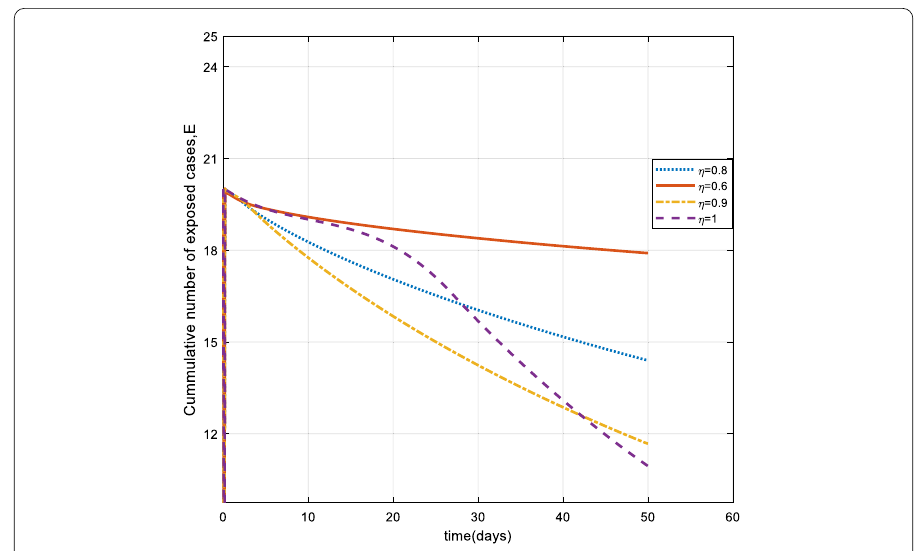
Figure 7 Number of exposed cases (E) with control for different values of the fractional derivative order η